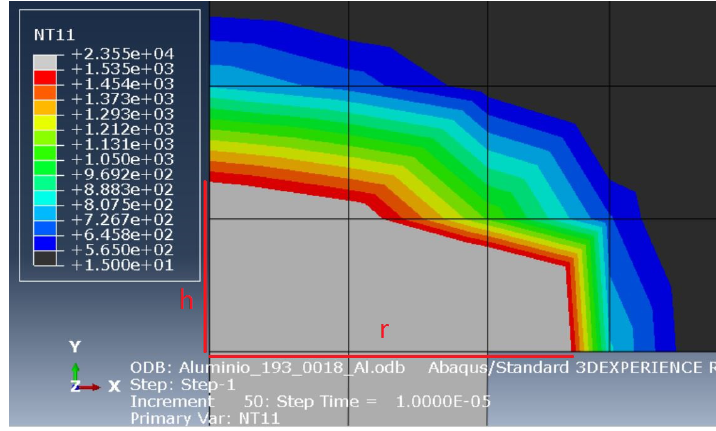
Figure 8. Measurement of the removed volume from the